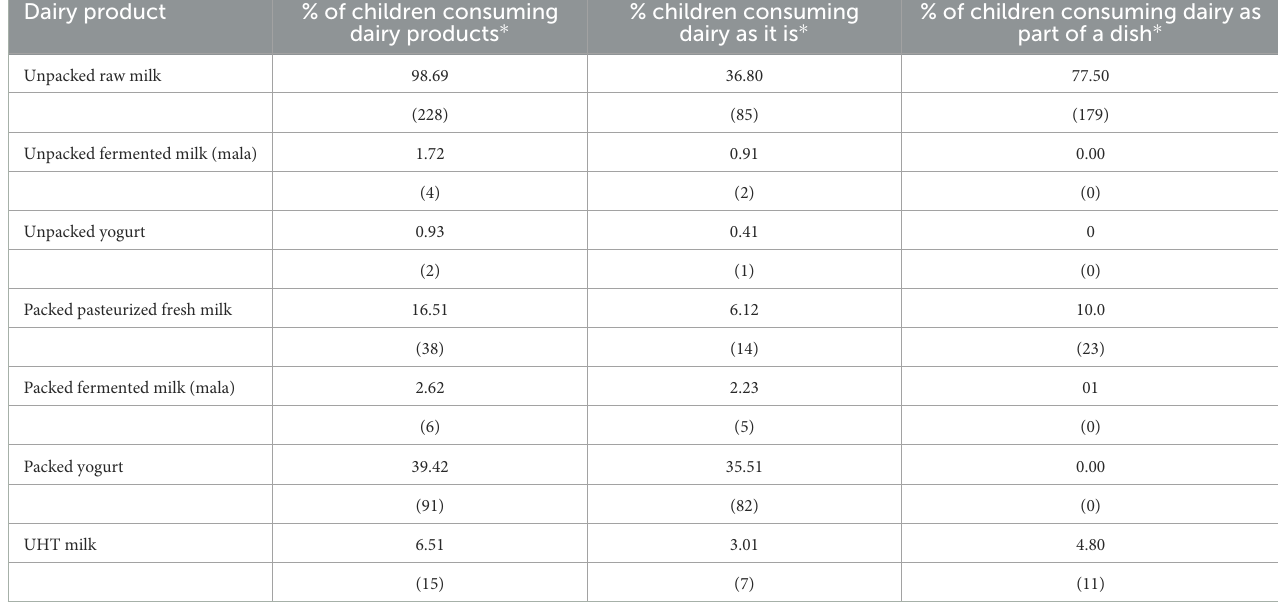
TABLE 5 Proportion of children between 6 and 48months consuming dairy products. Dairy product % of children consuming dairy products ∗